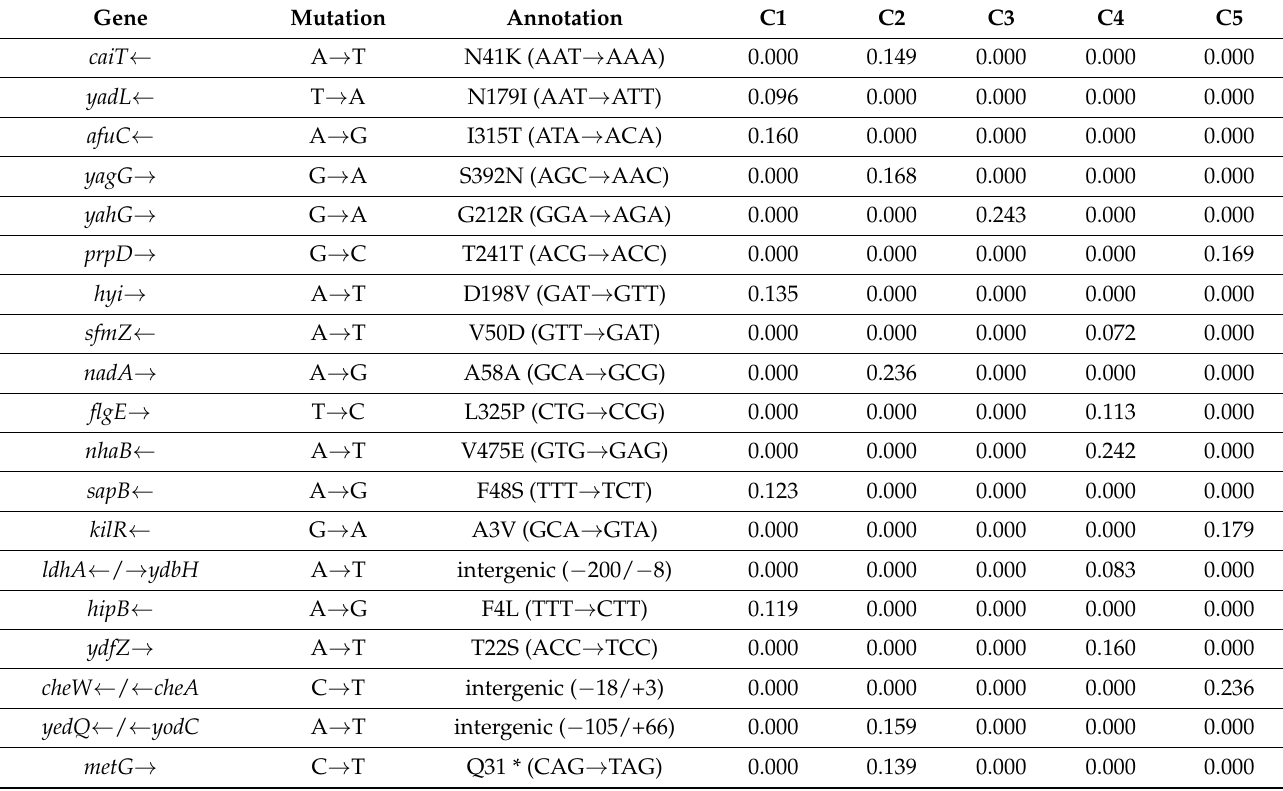
Table A4. Minor polymorphisms, control populations, day 28. Stop codons are symbolized as